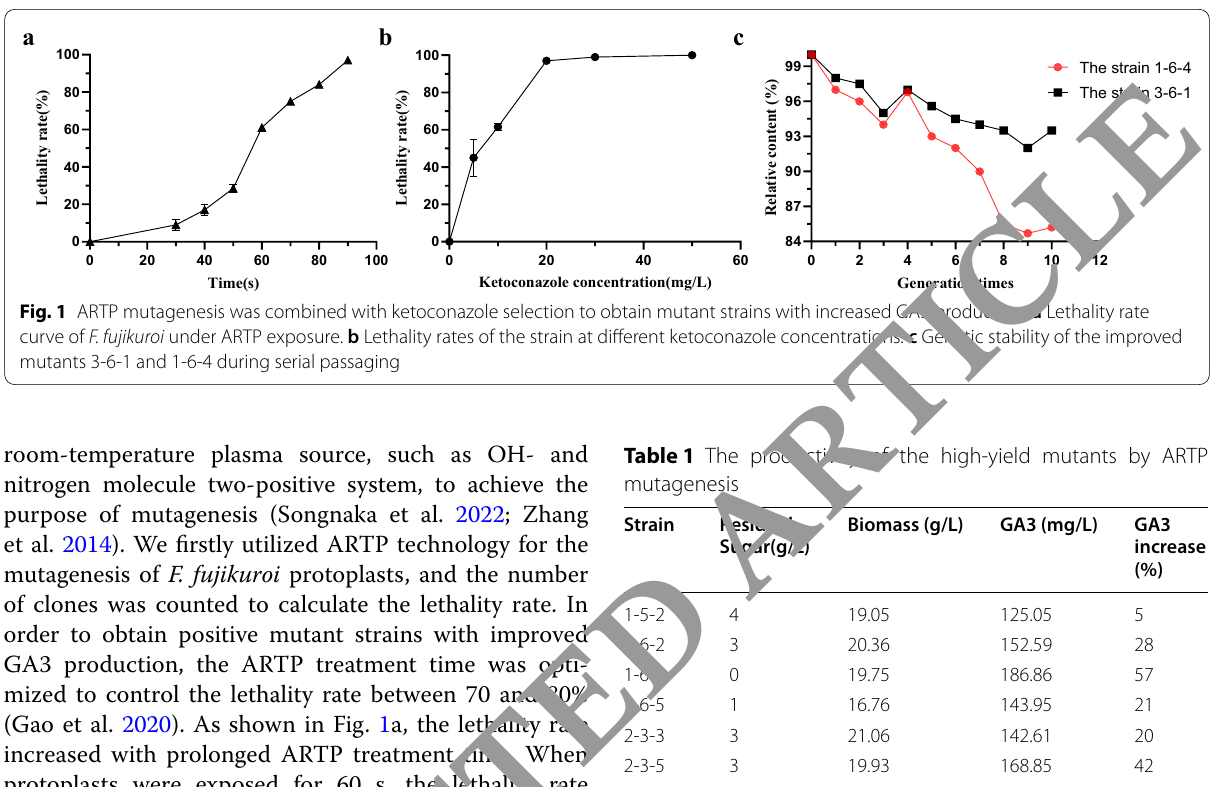
Table 1 The productivity of the high‑yield mutants by ARTP